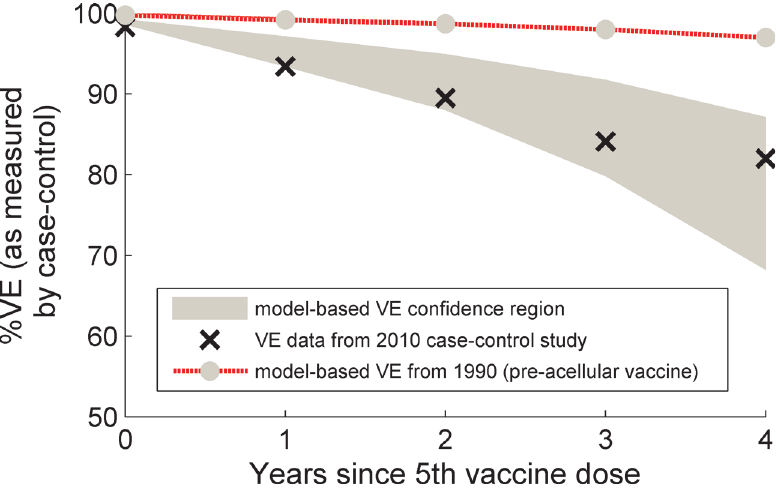
Fig 4. Case-control study results compared with modeled values. Vaccine Effectiveness (VE) as measured in the case-control study of Misegades et al [22] from 2010 in California (black crosses) compared with VE values generated by simulations of the case-control study using the model fitted to the incidence and these VE data (gray region). The gray shaded region represents the 95% credible interval of the model outputs. The dotted curve lying above the 2010 data and simulations was calculated by simulating a 1990 case-control study, and shows significantly slower waning of the VE value.